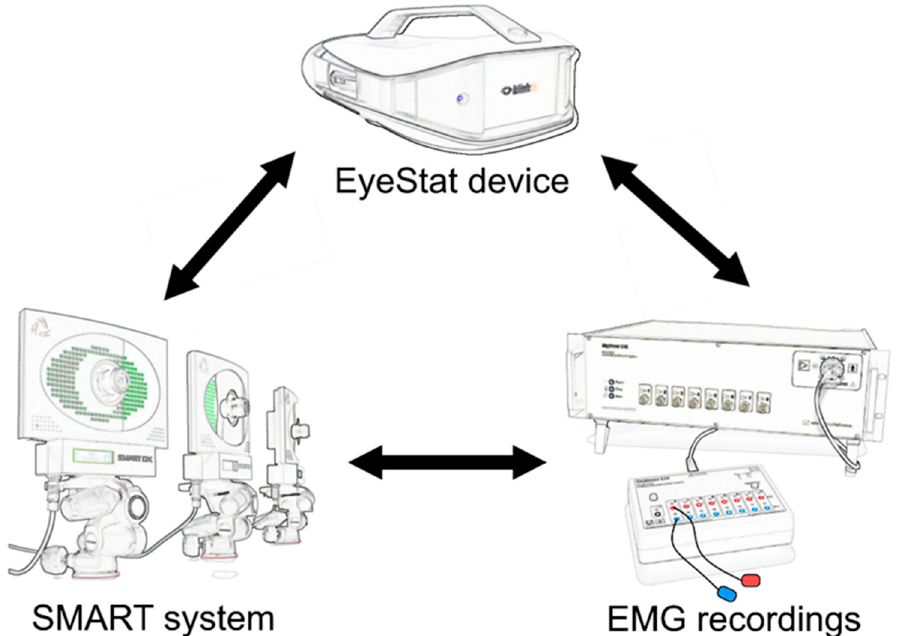
Figure 1. Methods used to record blinking . Three methods were used to record voluntary, spontaneous, and reflex blinking. The EyeStat device (Generation 3, Blinktbi, Charleston, SC, USA) and the SMART motion analysis system (BTS, Milan, Italy) were applied in a randomized order. An electromyographic (EMG) recording system was also used to simultaneously record every blinking movement trial.